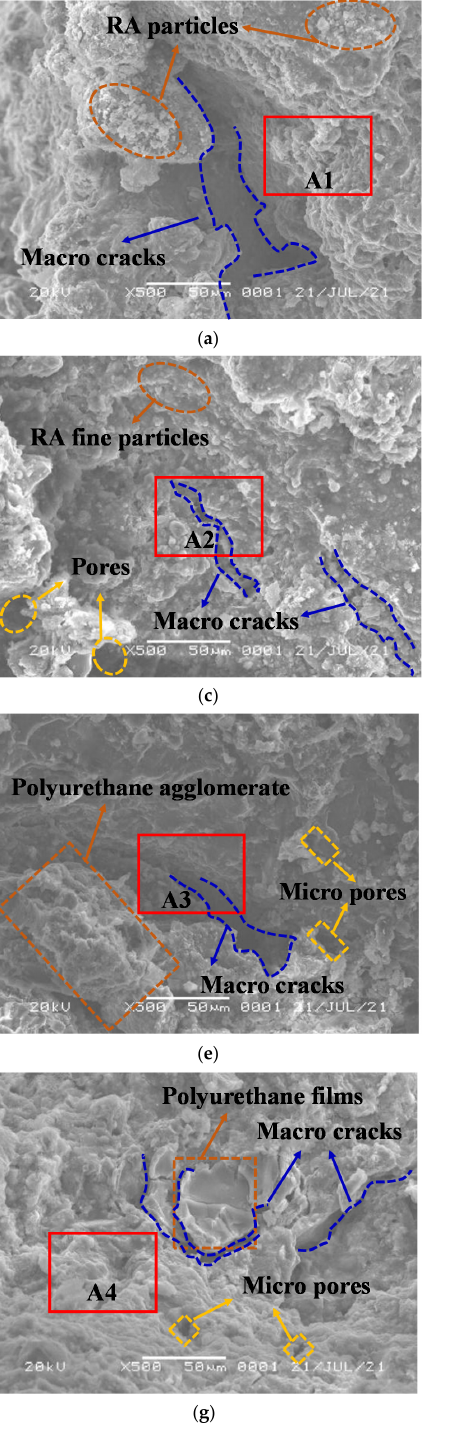
Figure 12. SEM images of PURD with different WPU contents. ( a ) PURD-3, 500 times; ( b ) PURD-3, 2000 times; ( c ) PURD-4, 500 times; ( d ) PURD-4, 2000 times; ( e ) PURD-5, 500 times; ( f ) PURD-5, 2000 times; ( g ) PURD-6, 500 times; ( h ) PURD-6, 2000 times.